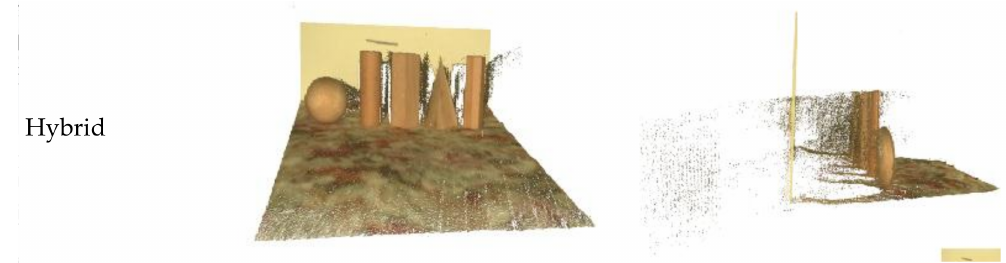
Figure 15. Qualitative evaluation for different structured light patterns projected through the FPGA.